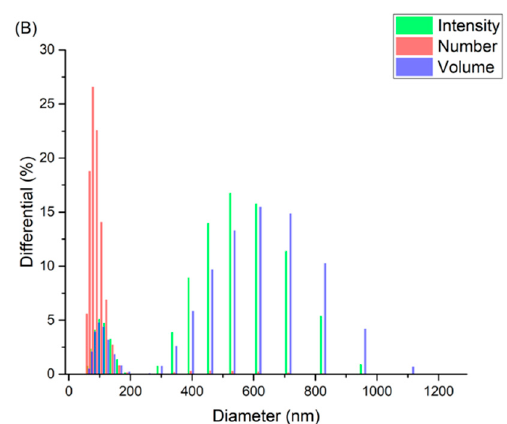
Figure 1. Histograms of the intensity-, volume-, and number-averaged hydrodynamic diameters of ( A ) unloaded and ( B ) chloroquine-loaded niosomal dispersions.